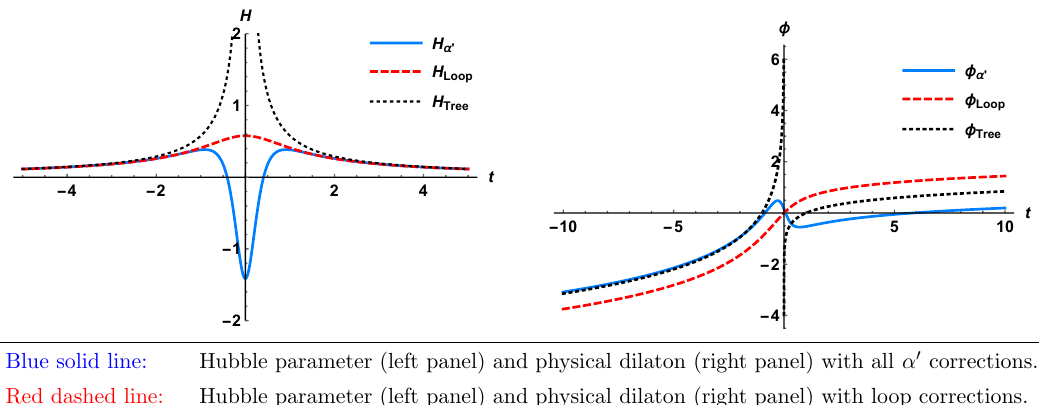
Hubble parameter (left panel) and physical dilaton (right panel) with all (cid:11) 0 corrections. Red dashed line: Hubble parameter (left panel) and physical dilaton (right panel) with loop corrections. Black dotted line: Tree level Hubble parameter (left panel) and physical dilaton (right panel). Figure 3 . The Hubble parameters and physical dilatons computed with various corrections.